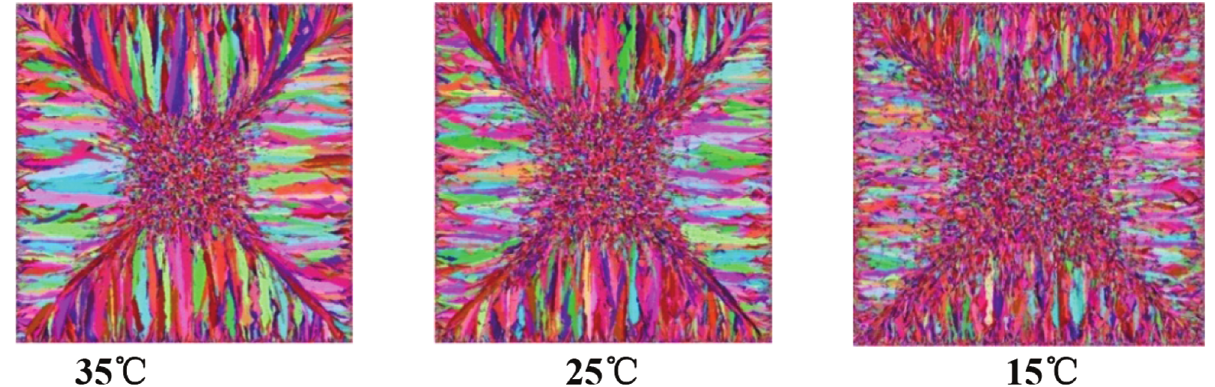
Figure 5: Simulated results of solidification structure at different superheat.